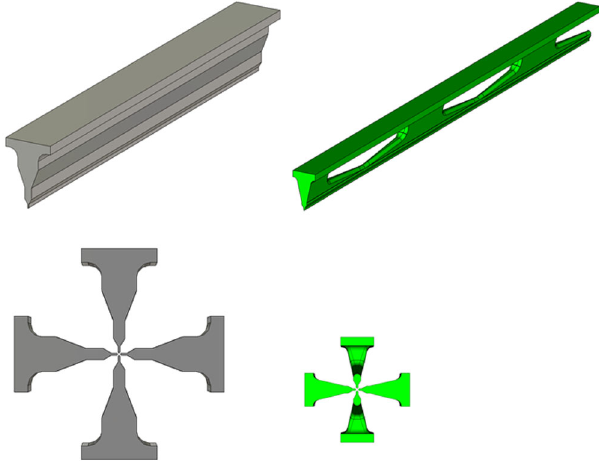
FIG. 1. Two design options for the RFQ vane. The first is a full vane (left) and the second has windows (right). The bottom plots show cross sections for both options scaled to the actual size. The transverse size is reduced from about 1 m to 0.5 m.